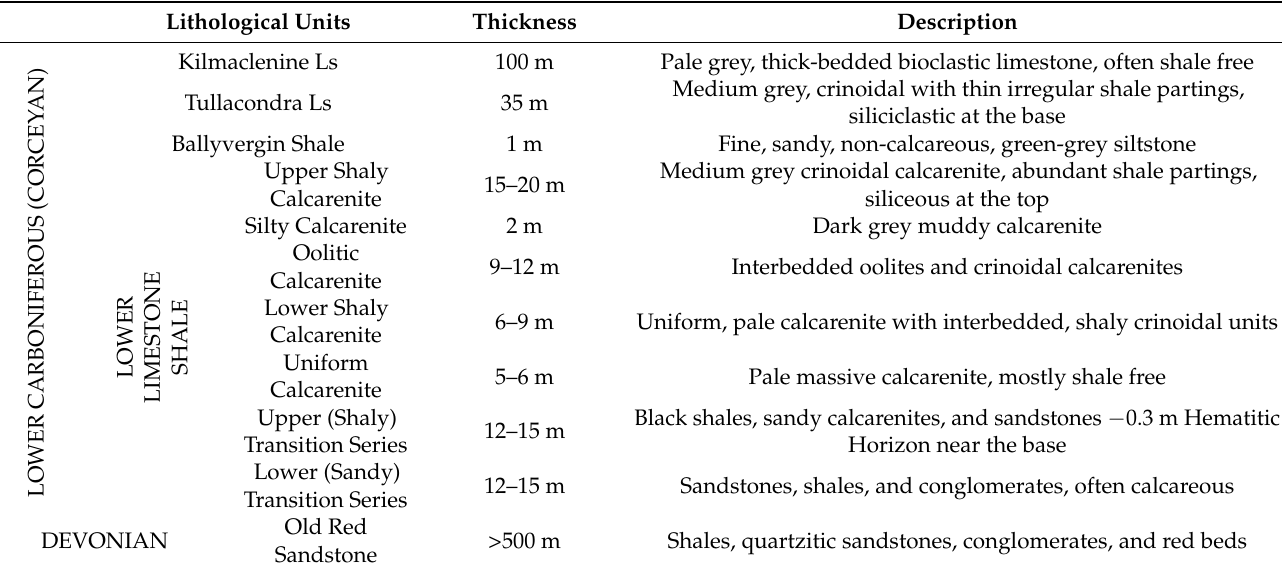
Table A1. Stratigraphy in the Tullacondra deposit according to [6].